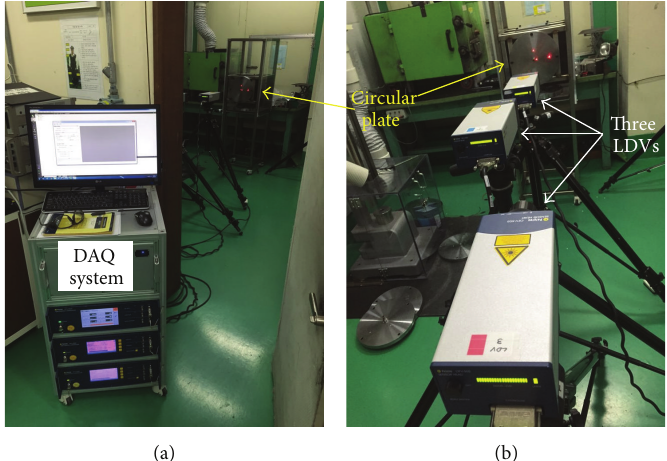
Figure 4: Experimental setup for pyroshock measurement: (a) DAQ system and (b) three LDVs. Acceleration, experiment 1